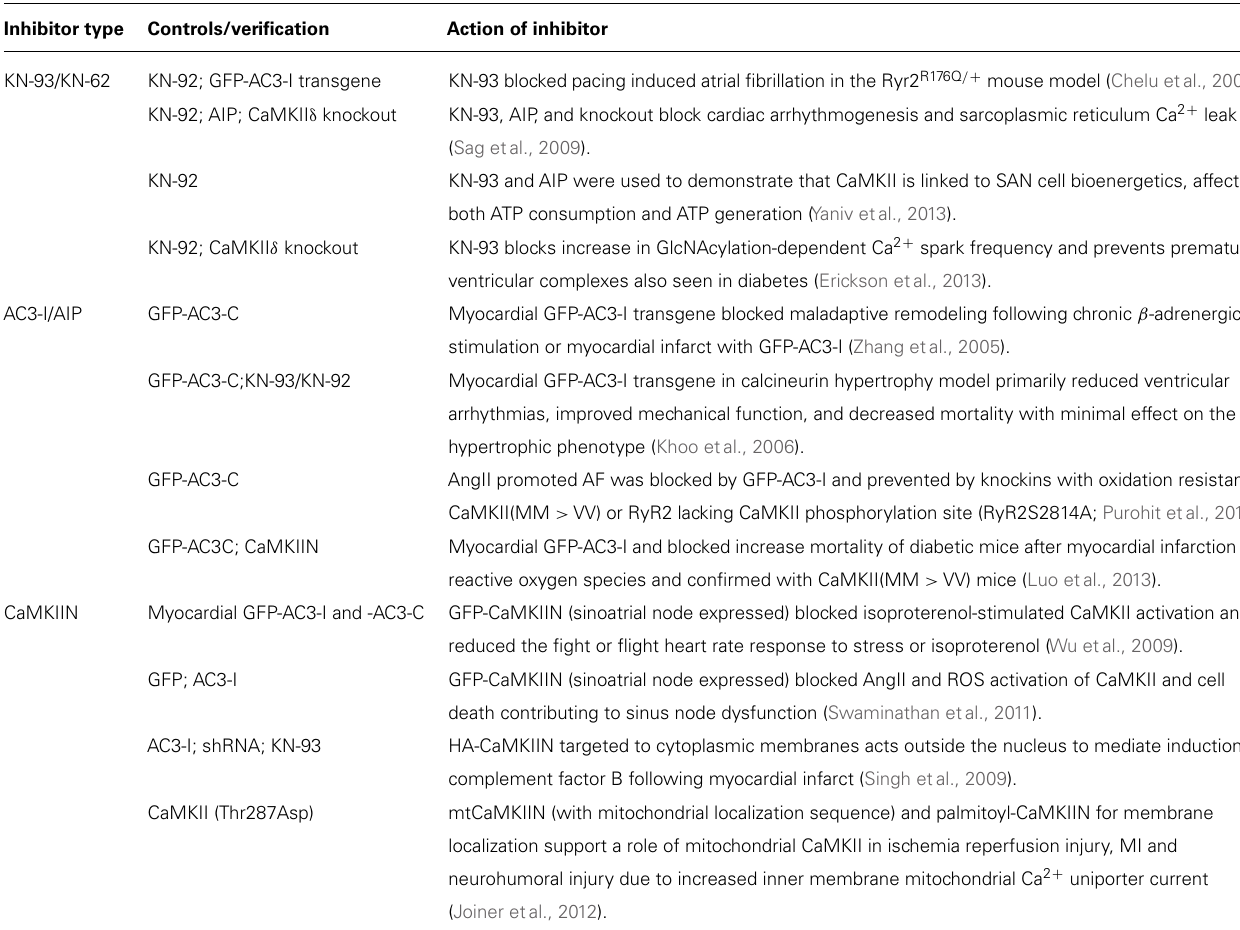
Table 1 | CaMKII inhibitors and related